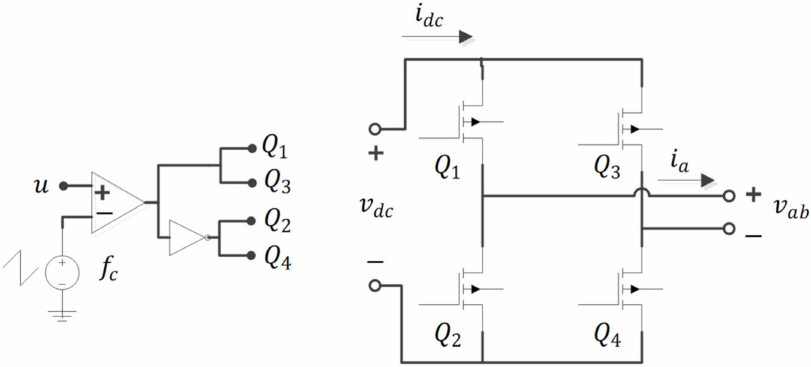
Figure 2. Schematic SPWM modulator and the stage formed by the power